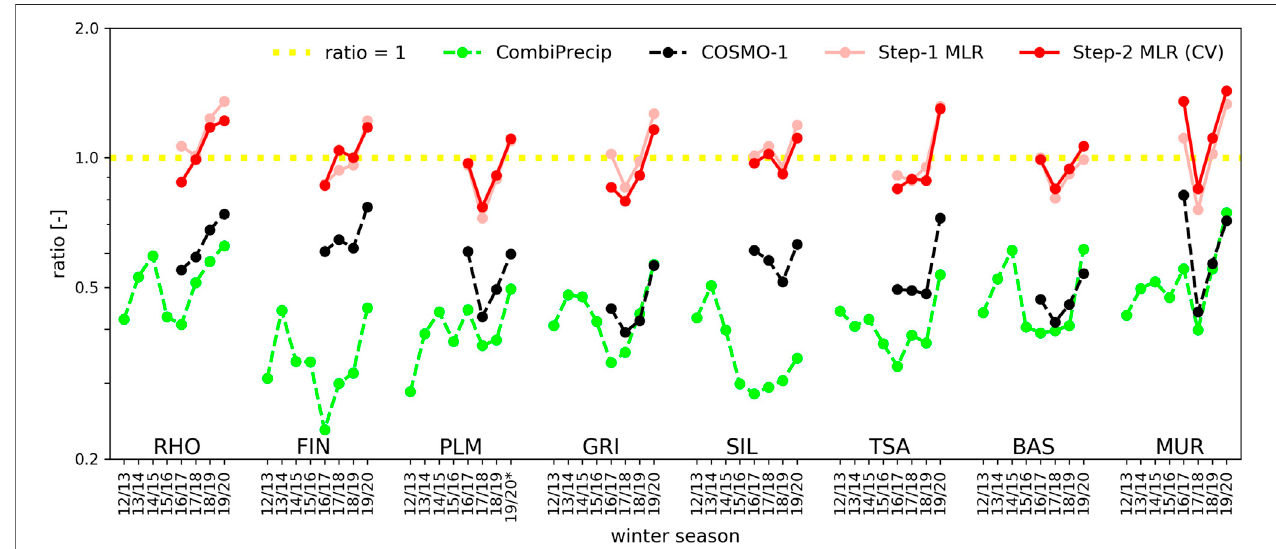
FIGURE7| RatioofthecumulativeprecipitationoftheprecipitationproductstotheSWEs,asestimatedwiththedifferentmodels,andtheend-of-seasonglacier-widewinter mass balance. *The 19/20 ratio for the Plaine Morte glacier was derived considering the CRS observations as no manual measurement were conducted in this winter season.